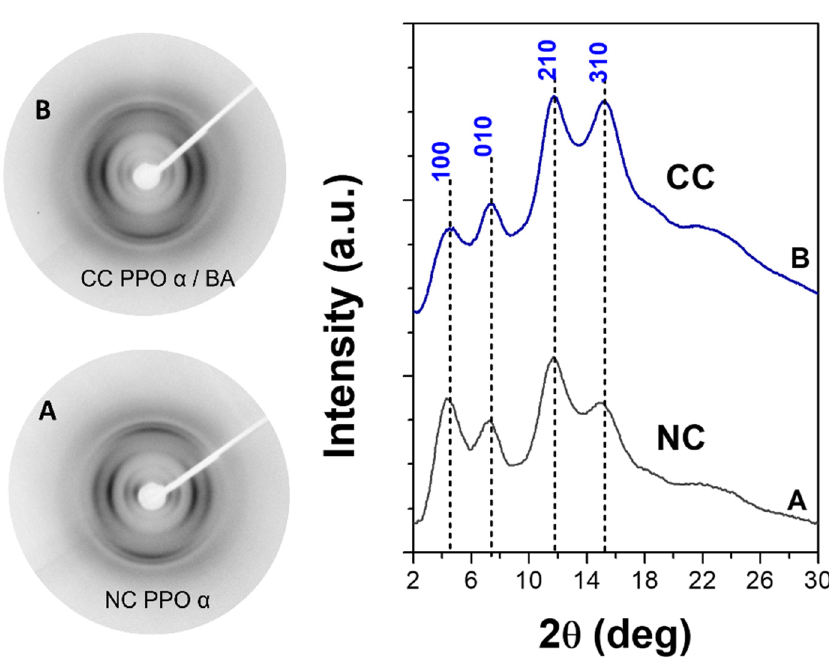
Figure 5. Two-dimensional wide-angle X-ray diffraction patterns and related equatorial intensity profiles of axially oriented PPO films presenting the ( A ) NC α form and ( B ) CC α form with BA. Miller indexes of relevant equatorial reflections of the CC phase are indicated.